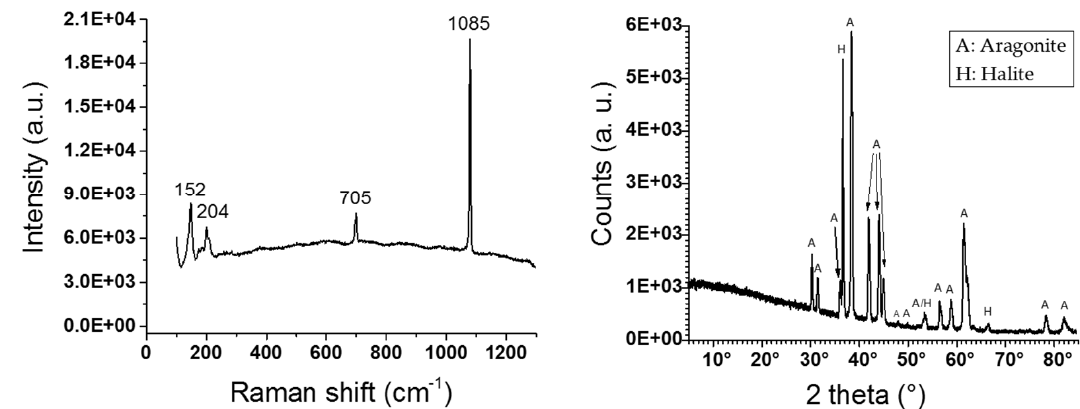
Figure 9. Raman and XRD (X-ray diffraction) of defect area of sample exposed to artificial seawater (SW) for 50 days in controlled laboratory conditions.